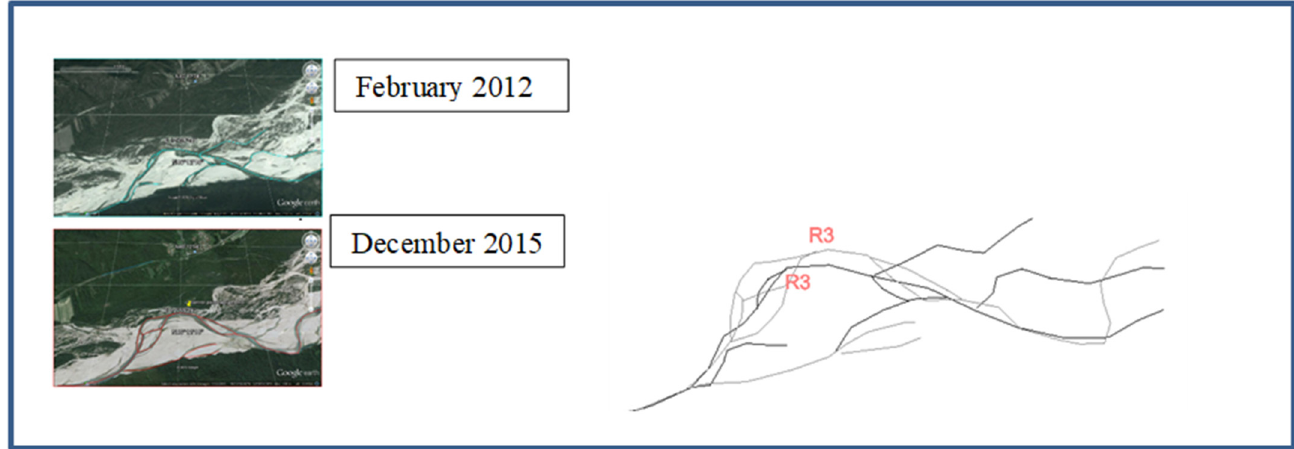
Figure 9. Comparisons between the tracers in February 2012 (in black) and December 2015 (in grey) (images obtained from Google Earth, Image ©2015 DigitalGlobe).